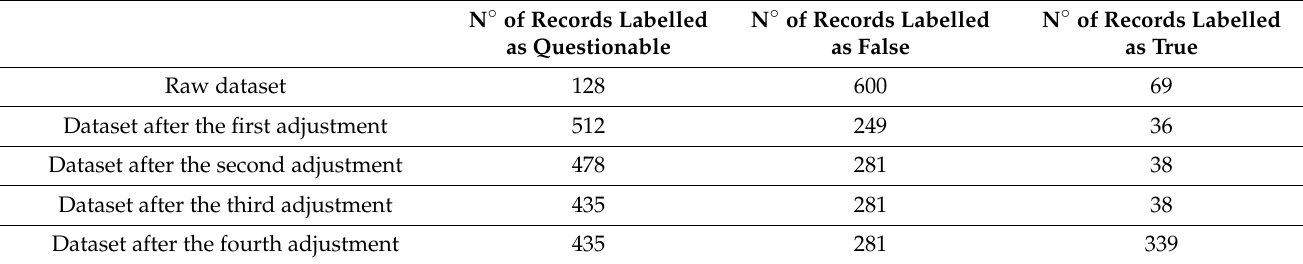
Table 2. Composition of the infodemic 2019